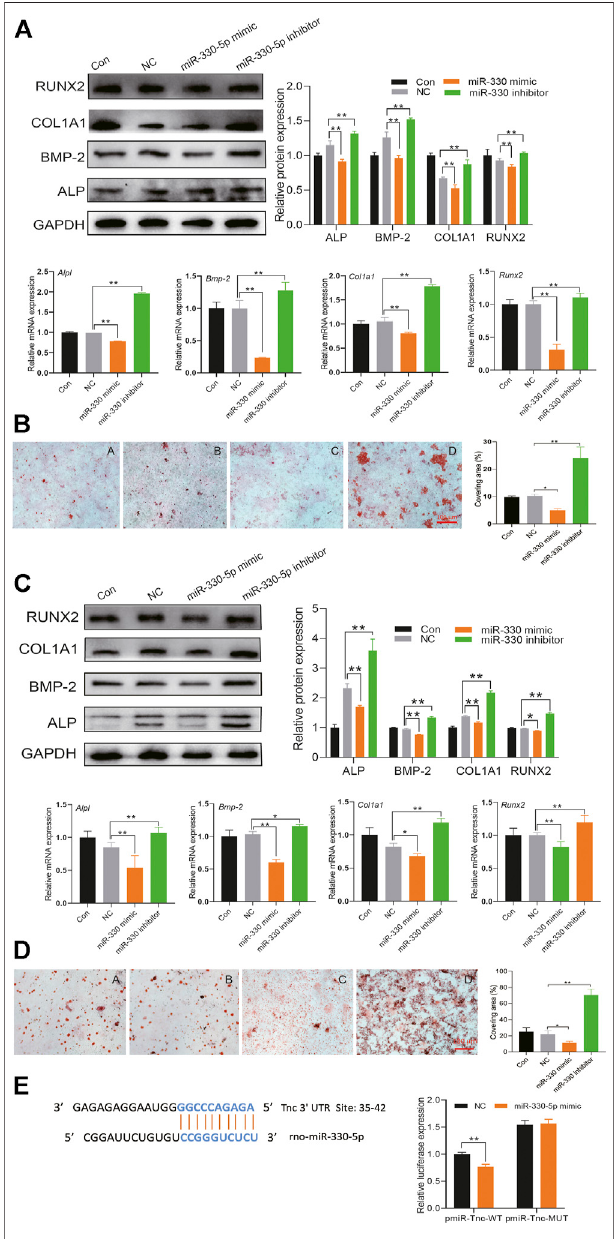
FIGURE 6 | miR-330 – 5p targeted Tnc to attenuate osteogenic differentiation in BMSCs and pre-osteoblasts. (A) The protein and mRNA expression of osteogenic differentiation when overexpressing or inhibiting miR-330 – 5p in BMSCs, the normalized data represented the mean ± SD; (B) The representative pictures of alizarin red s staining in BMSCs, scale bar:100 μ m (A) Con (B) NC (C) miR-330 – 5pmimic (D) miR-330 – 5pInhibitor; (C) the protein and mRNA expression of osteogenic differentiation when overexpressing or inhibiting miR-330 – 5p in pre-osteoblasts, the normalized data represented the mean ± SD; (D) The representative pictures of alizarin red s staining in pre-osteoblasts, scale bar: 100 μ m (A) Con (B) NC (C) miR- 330 – 5p mimic (D) miR-330 – 5p Inhibitor; (E) The dual- fl uorescence reporter assay identify the af fi nity of Tnc and miR-330 – 5p. * p < 0.05, ** p < 0.01, analyses were done twice and obtained comparable